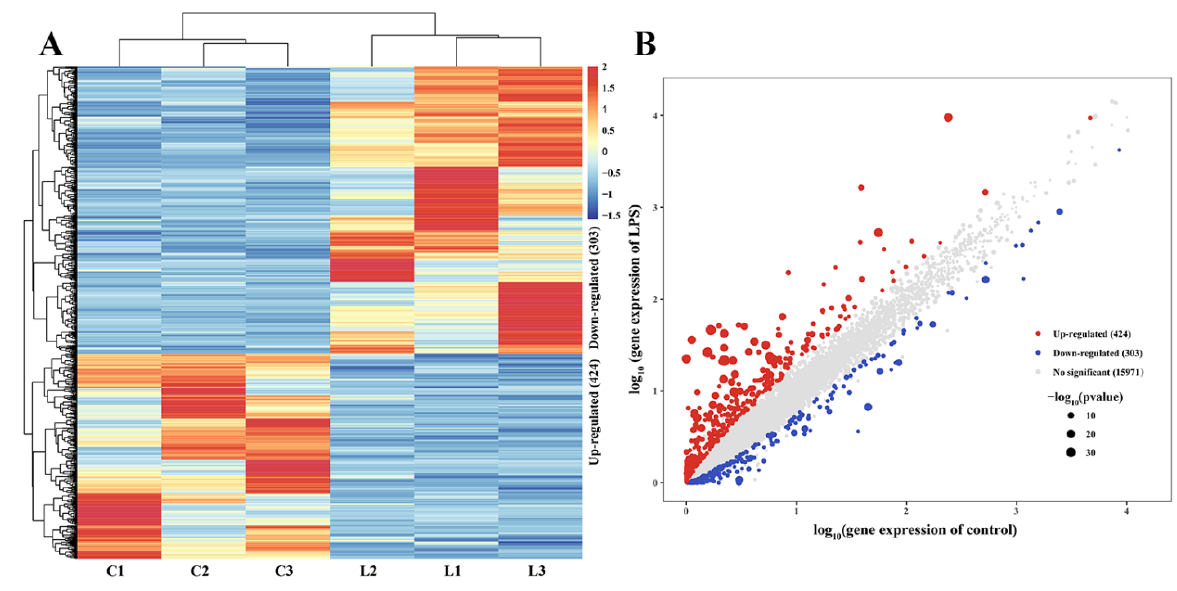
Figure 4. Differentially expressed genes in the livers of the control and LPS groups of goslings. ( A ) The heat map of control group vs. LPS group differentially expressed genes. ( B ) Gene expression distribution scatter plot. Blue dots indicated downregulated genes, red dots indicated upregulated genes, gray dots indicated non-differently expressed genes, and the sizes of the dots indicated the significance of the genes.